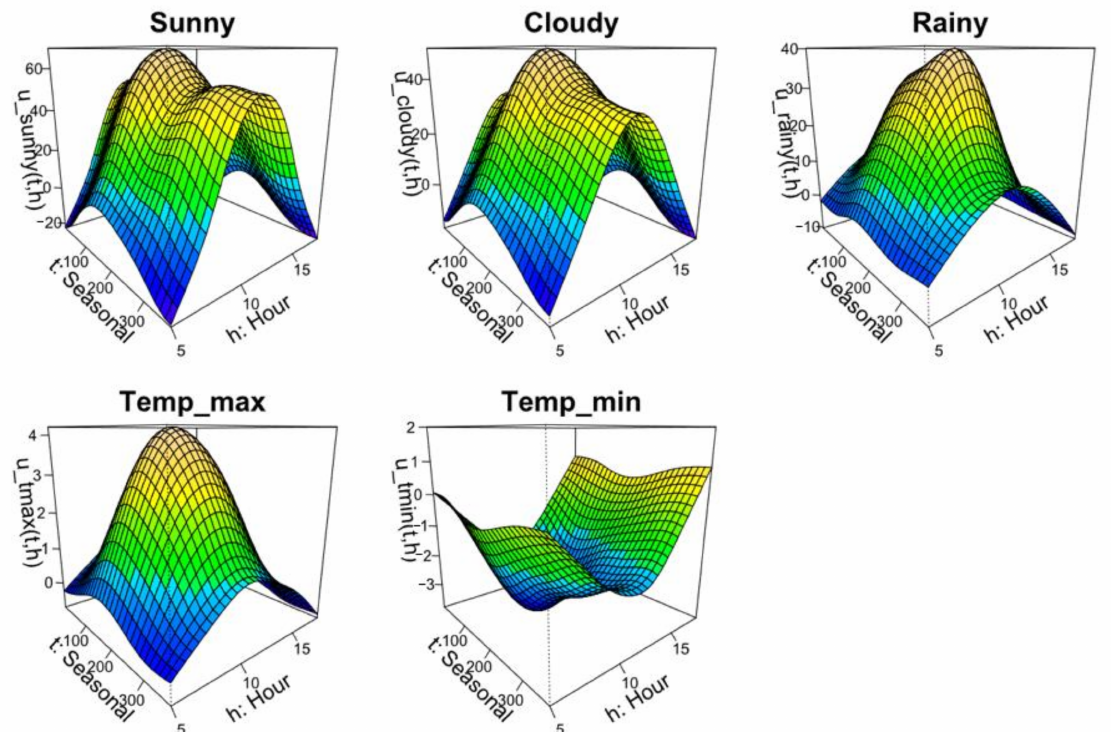
Figure 2. Estimated trends for areawide PV power generation model (example of Tokyo area). Note: The unit of vertical axis for “Sunny,” “Cloudy” and “Rainy” is (%), and that for “Temp_max” and “Temp_min” is (%/ ◦ C). “Seasonal” denotes a yearly cyclical dummy variable (see Section 2.1), and “Hour” denotes the time